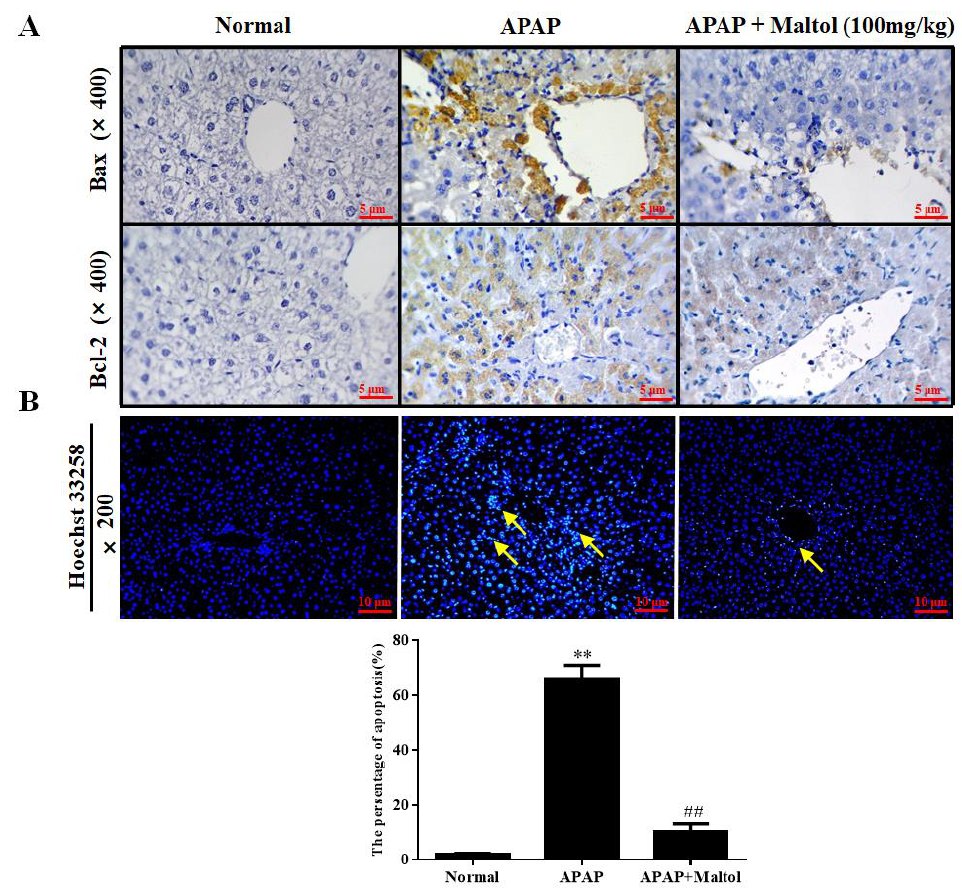
Figure 4. Effects of maltol pretreatment on the expression of B-associated X (Bax) and B-cell-lymphoma-2 (Bcl-2) and Hoechst 33258 staining in liver tissues. ( A ) The protein expression levels of Bax and Bcl-2 were examined by immunohistochemistry in liver tissues (magnification, ×400). ( B ) Hoechst 33258 staining (magnification, ×200). Arrows show necrotic and injured cells. All data are expressed as mean ± S.D., n = 8; ** p < 0.01 vs normal group; ## p < 0.01 vs APAP group.